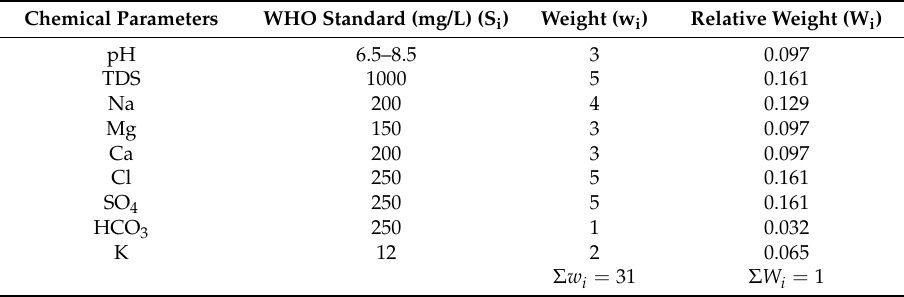
Table 1. Weight and relative weight of each chemical parameter.